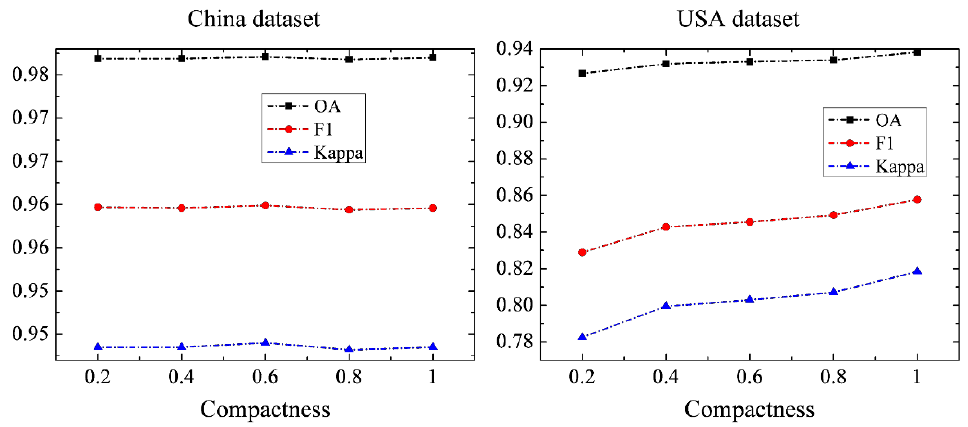
Figure 15. SSCF experiments using different compactness w .